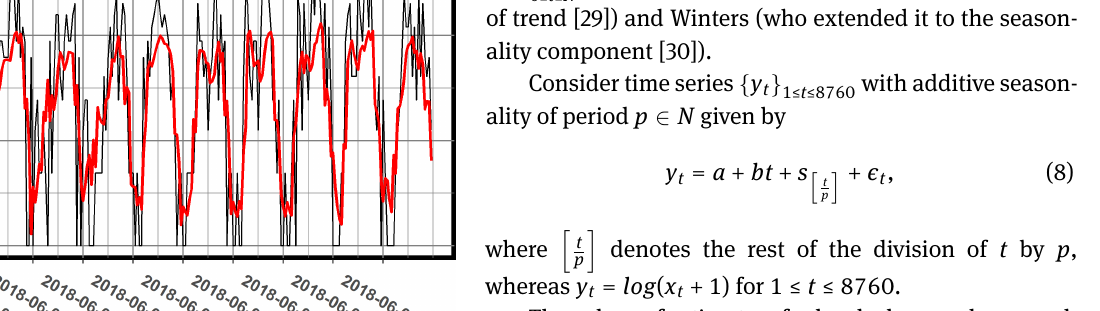
Figure 8 shows goodness of fit of residual distribution ε t to normal distribution N (0, 0.266).